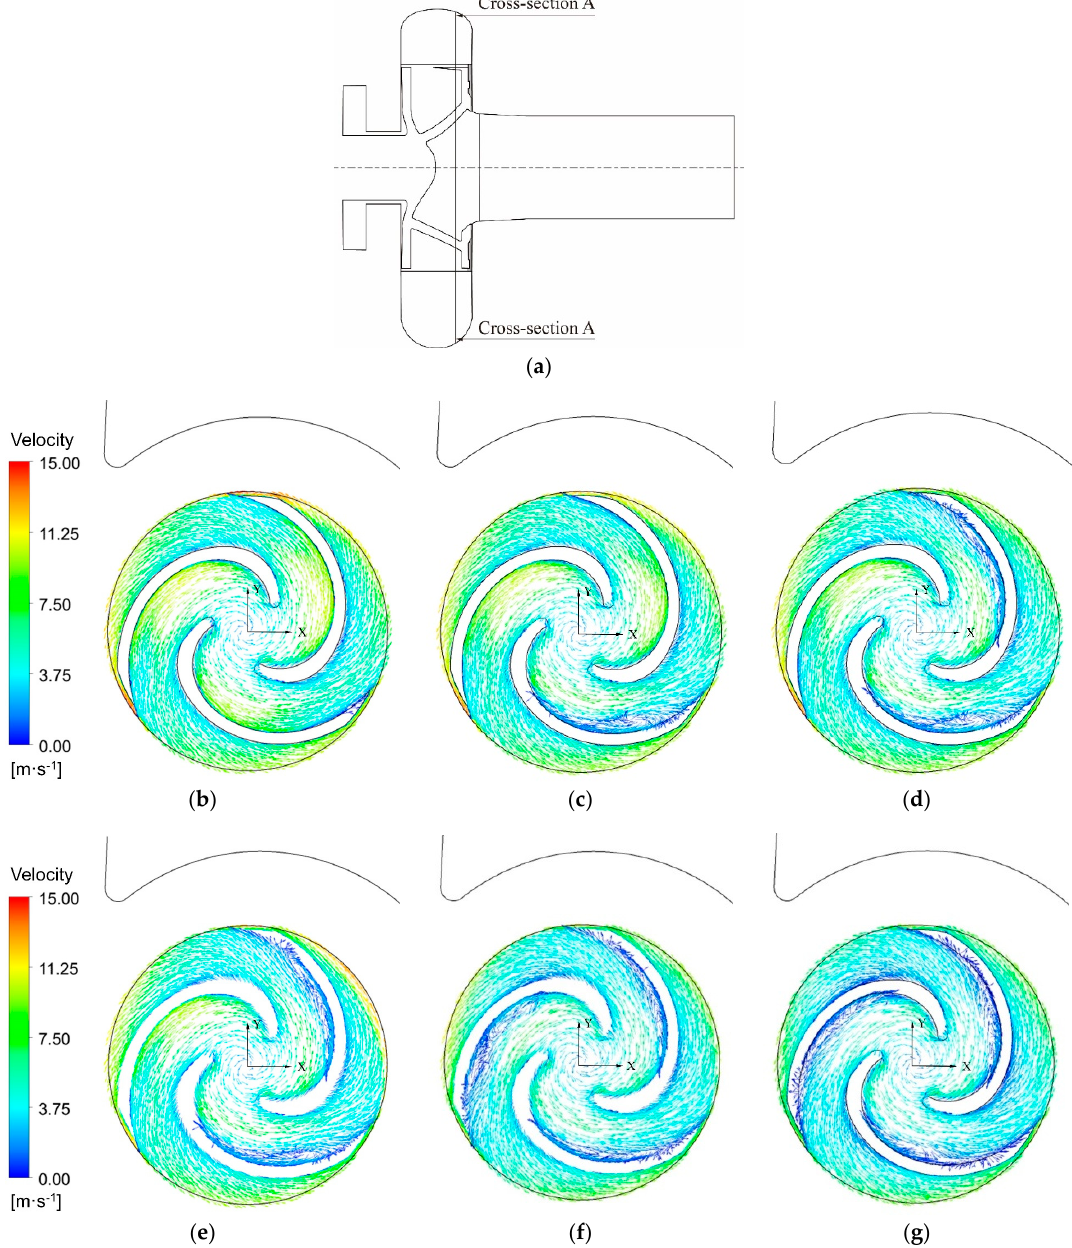
Figure 10. Relative flow velocity vector on the cross-section A at the design and part-load operating conditions, ( a ) cross-section A; ( b ) 1.0 × Q 0 ; ( c ) 0.9 × Q 0 ; ( d ) 0.8 × Q 0 ; ( e ) 0.7 × Q 0 ; ( f ) 0.6 × Q 0 ; and ( g ) 0.5 × Q 0 .